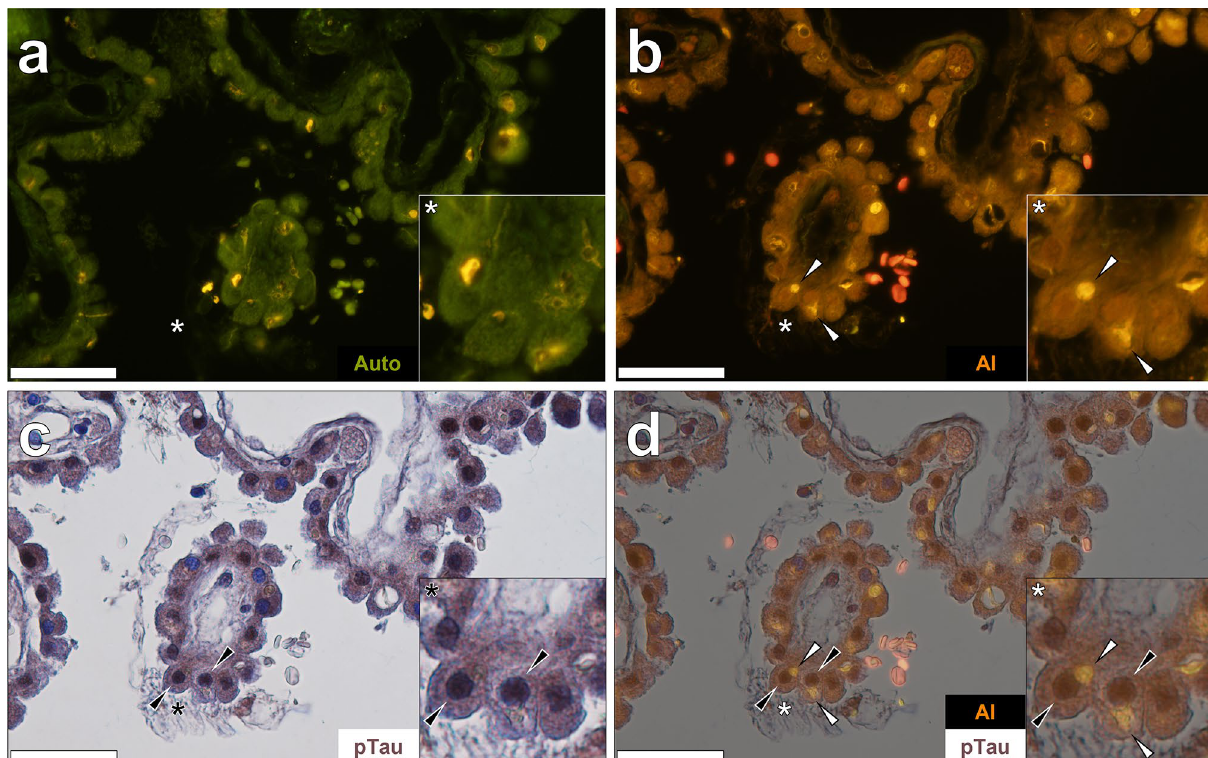
Figure 4. Aluminium in Biondi inclusions co-deposited with phosphorylated tau (pTau) in epithelial cells lining the choroid plexus of a 67-year-old female donor with Parkinson’s disease. ( a ) Autofluorescence highlighting intracellular lipofuscin. ( b ) Biondi inclusions (white arrows) positive for aluminium (Al, orange). ( c ) AT8 immunolabelled pTau (black arrows). ( d ) Merging of the brightfield and lumogallion fluorescence channels reveal that Biondi inclusions and aluminium are adjacently located in the same cells. Asterisks denote magnified inserts. Magnification: × 400, scale bars: 50